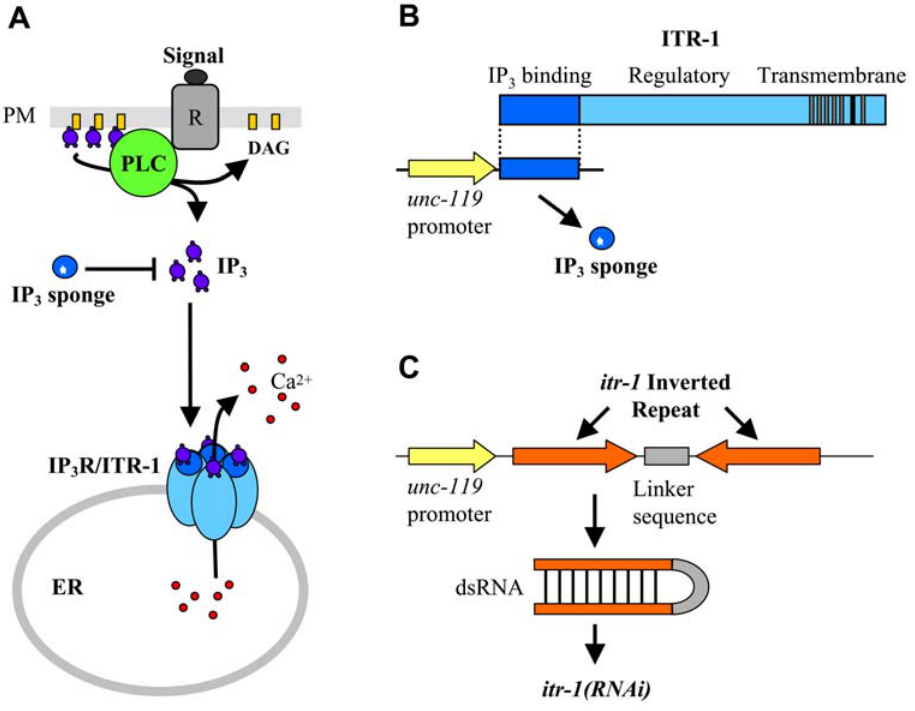
Figure 1. Disruption of IP 3 signalling in the nervous system. (A) Schematic diagram showing the IP 3 signalling cassette. Stimulation of a receptor (R) at the cell surface leads to the activation of phopholipase C (PLC), which catalyses the hydrolysis of phosphatidylinositol 4,5- bisphosphate to produce inositol 1,4,5-trisphosphate (IP 3 ) and diacylglycerol (DAG). IP 3 diffuses to the endoplasmic reticulum (ER), where it activates the IP 3 receptor (IP 3 R), resulting in the release of Ca 2 + into the cytoplasm. Expression of an IP 3 sponge [see (B)] should mop up free IP 3 , thus interfering with its ability to activate IP 3 Rs. (B) Strategy used to disrupt IP 3 signalling in the nervous system using IP 3 sponges. ITR-1, the C. elegans IP 3 R subunit, consists of 3 functional regions, including an IP 3 binding domain. Overexpression of the binding domain allows it to act as an IP 3 sponge. Expression under the control of the unc-119 promoter leads to nervous system-wide expression of the IP 3 sponge. (C) Strategy used